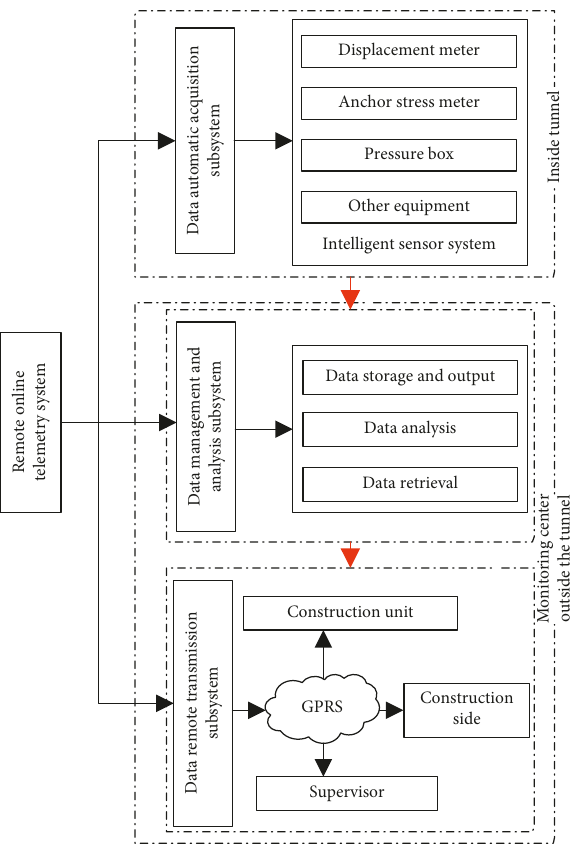
Figure 1: Configuration of the remote automatic monitoring